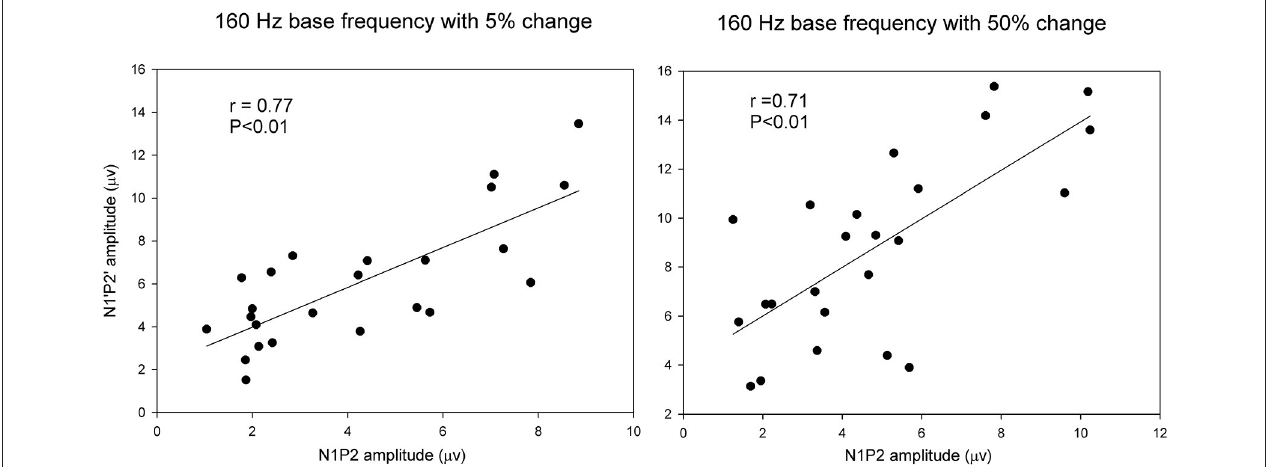
FIGURE 5 | Scatter plots of ACC amplitude vs. onset LAEP amplitude for the 160Hz base frequency with 5 and 50% frequency changes. Data from participants in both musicians and non-musician groups were included. The solid lines show linear regressions fit to the data. The r -value for each fit is shown in each